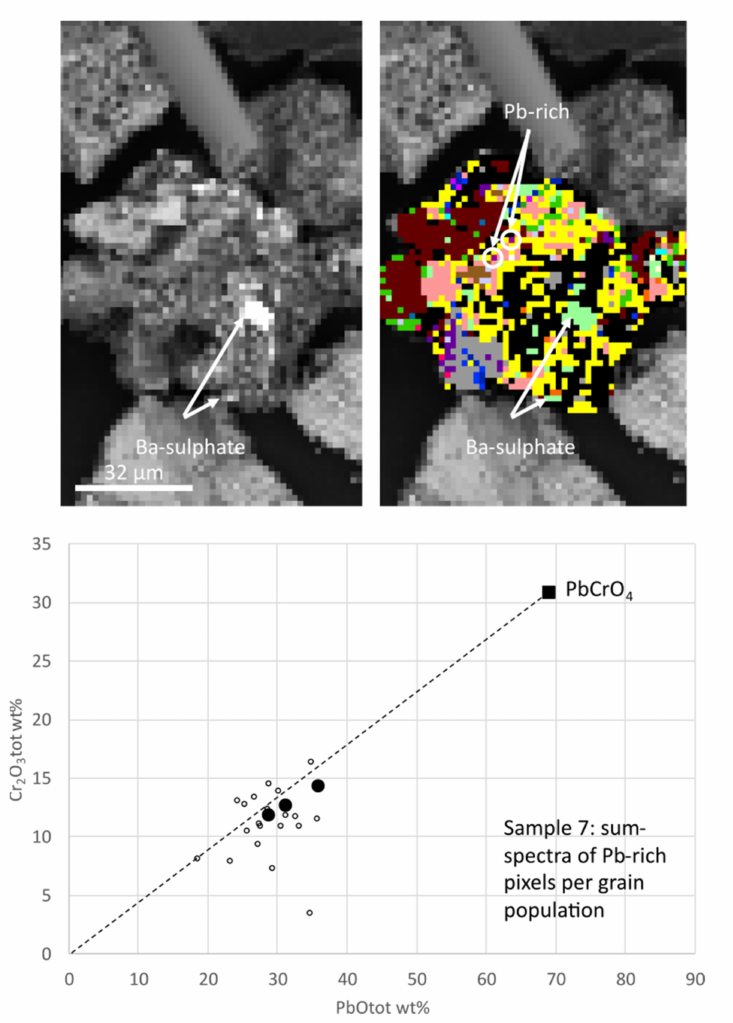
Figure 18. (Image) Typical Pb-rich occurrence in sample 7 grains—two isolated Pb-rich pixels on the surface of a grain with additionally Ba-sulphate pixels (left, BSE; right, PARC phase map). Such occurrences dominate the contribution to total Pb-rich pixels in sample 7. (Plot) Quantitative EDS analyses of sum-spectra for Pb-rich pixels from sample 7, grouped by grain population. Sum-spectra based on 10–50 pixels (total) are shown as smaller unfilled circles. Three spectra based on >50 pixels are shown with larger filled circles. The line represents a mixing line between the composition of PbCrO 4 and generic Pb- and Cr-free material, expected in case of mixed chemical signal in the pixels. Note the clustering of most of the data points close to the line. Full EDS quantitative analyses of PARC sum-spectra are given in Supplementary File